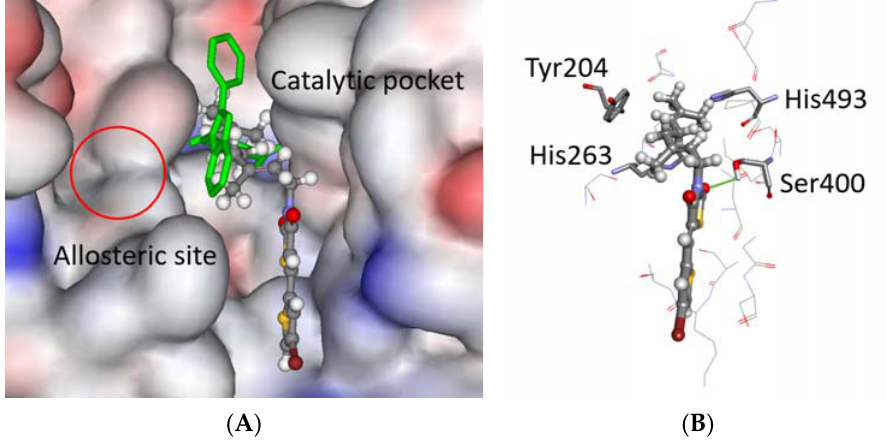
Figure 3. The docked pose of 21d in the catalytic site of TDP1, as predicted by the ChemPLP scoring function. ( A ) The ligand is shown in the ball-and-stick format. The catalytic pocket is at the right-hand site of the image and the co-crystallized ligand is depicted as green sticks. The allosteric pocket is not predicted to be occupied (see circled area). The protein surface is rendered; blue depicts regions with a partial positive charge on the surface; red depicts regions with a partial negative charge and grey shows neutral areas. ( B ) The predicted configuration is depicted as balls-and-sticks; H-bonding can be observed between one of the carbonyl groups in the thiazolidinedione ring and the side chain of Ser400 (stick format). The catalytic His263 and His493 amino acid residues are shown as sticks. The adjacent amino acids (<5 Å), buttressing the ligand, are shown as lines. The amino acids’ hydrogens are not shown for clarity.